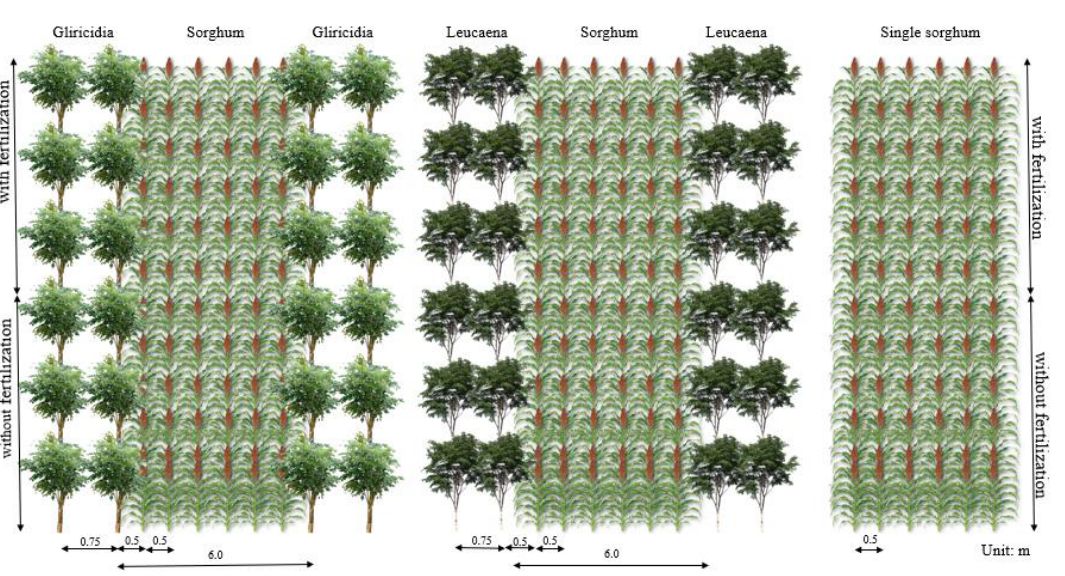
Table 2. Macronutrient content and dry mass of plant residues deposited between lines of sorghum cultivation (double crop) in March